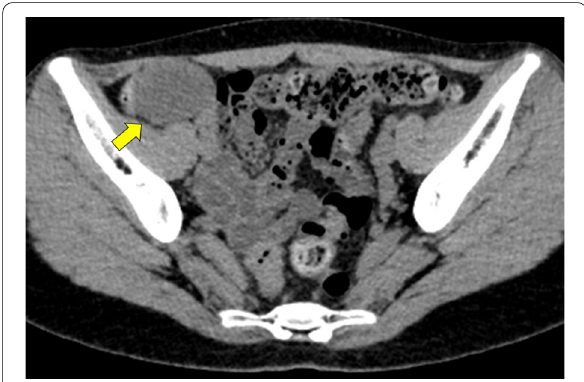
Fig. 2 Abdominal MRI. MRI reveals a 56 the cecum, appearing hypointense on T1-weighted imaging ( a ) and hyperintense on T2-weighted imaging ( b